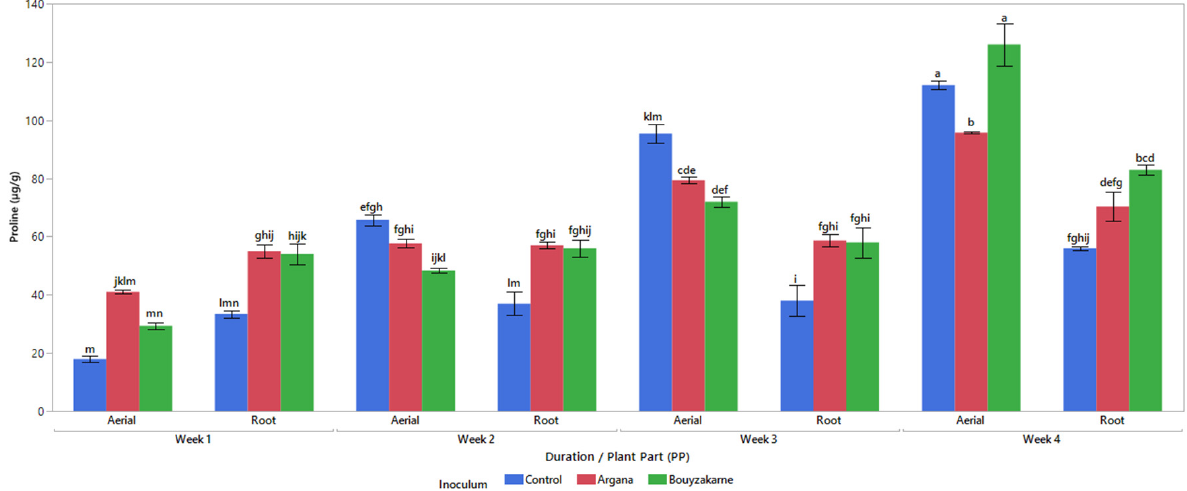
Figure 6. Proline content in the leaves and roots of mycorrhizal or non-mycorrhizal Argan plants subjected to soil water deficit stress for one month (each error bar is constructed using 1 standard error from the mean). Values with different letters are significantly different (Tukey’s test p ≤ 0.05).